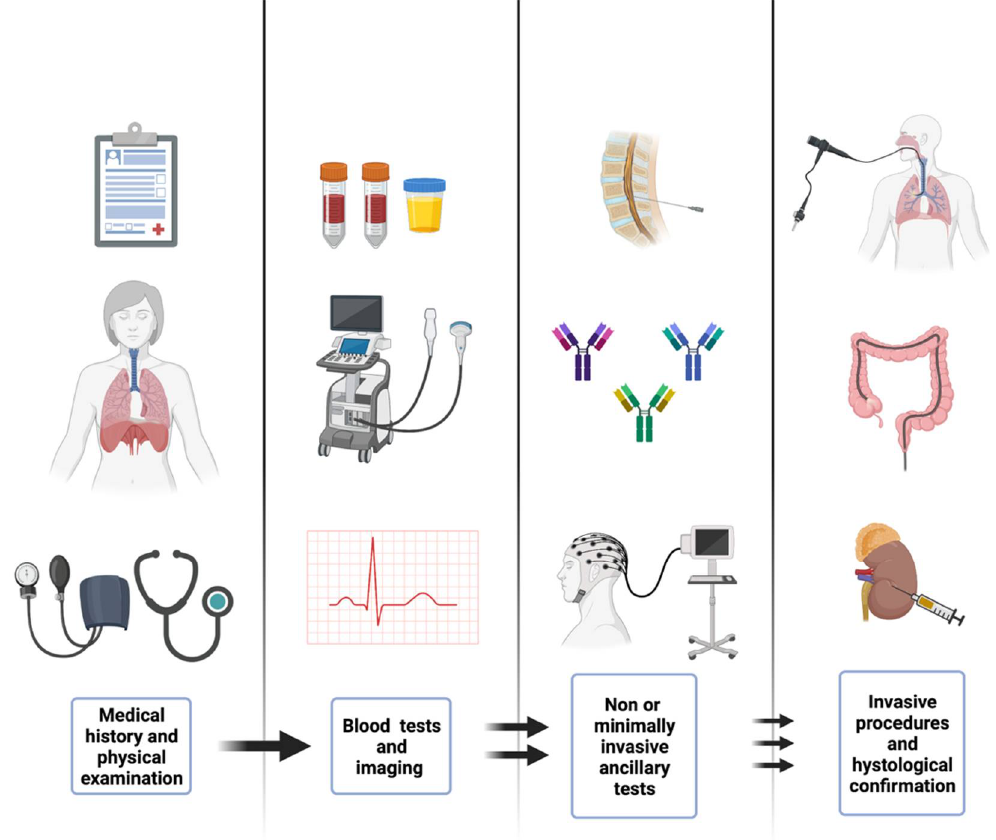
Figure 2. Proposed diagnostic workup for irAEs.